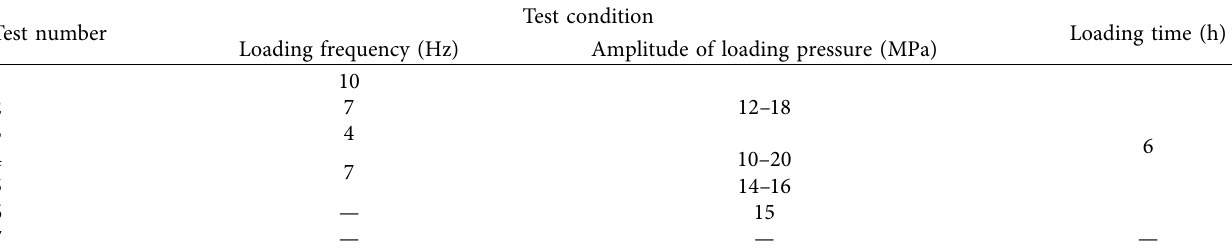
Table 2: Loading conditions for cyclic loading tests.